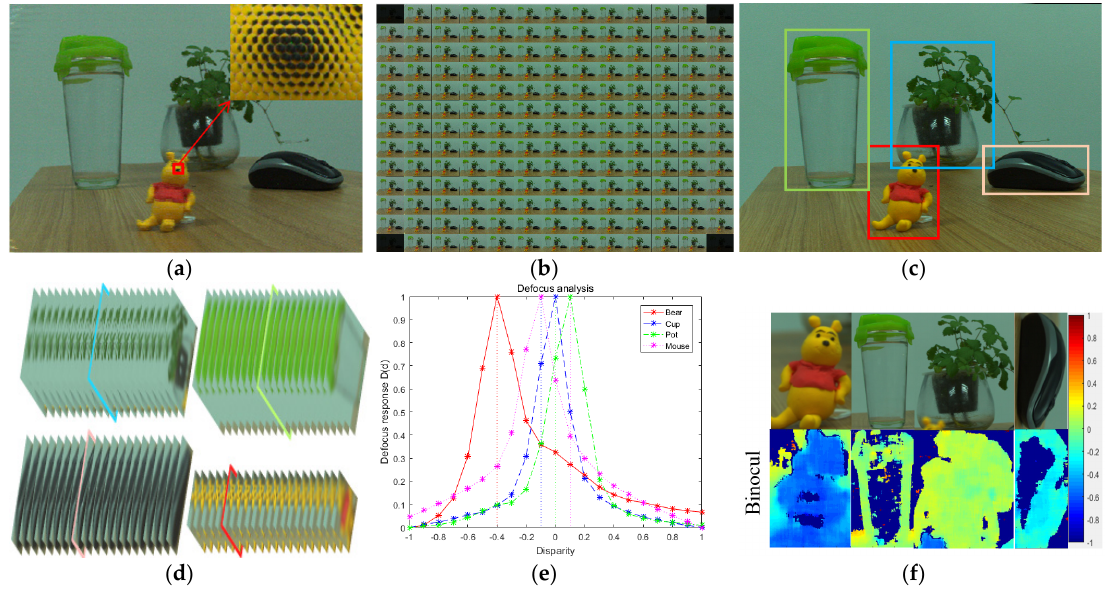
Figure 7. Application of the proposed method in real scene. ( a ) Light field data collected by Lytro Illum. ( b ) The decoded light field data. ( c ) Identified objects on all-in-focus image. ( d ) Focal stacks of object regions. ( e ) Depth estimation by defocus response. ( f ) Depth estimation per pixel by multi-baseline stereo matching.